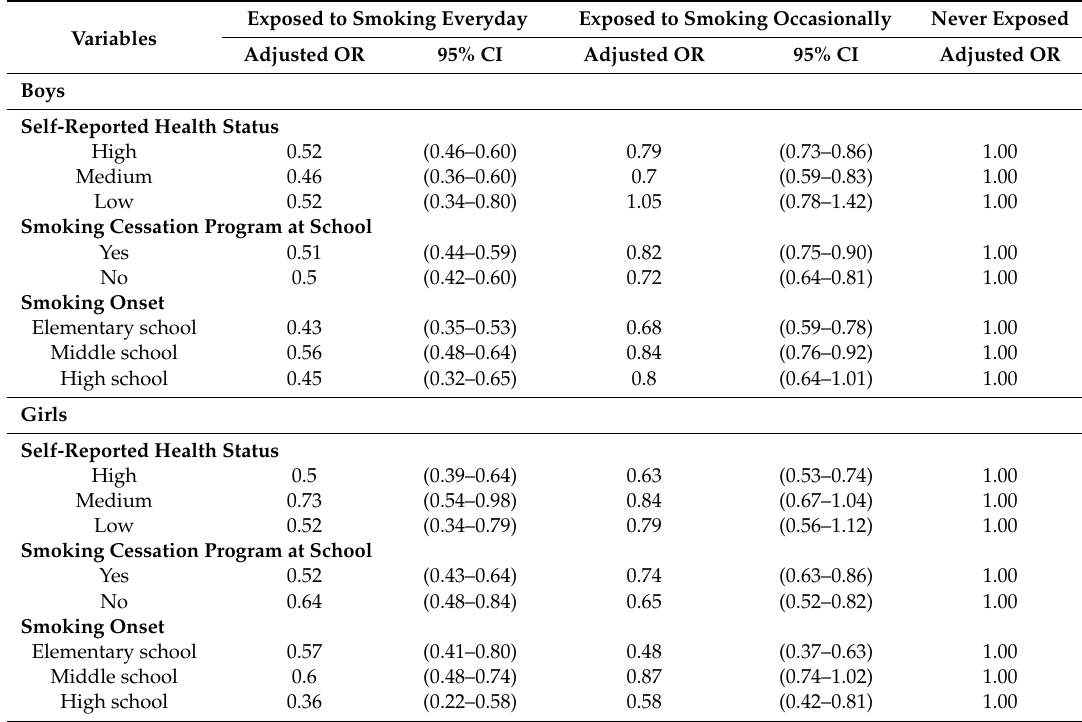
Table 4. Subgroup analysis, representing the odds ratios for smoking cessation, stratified by smoking exposure at